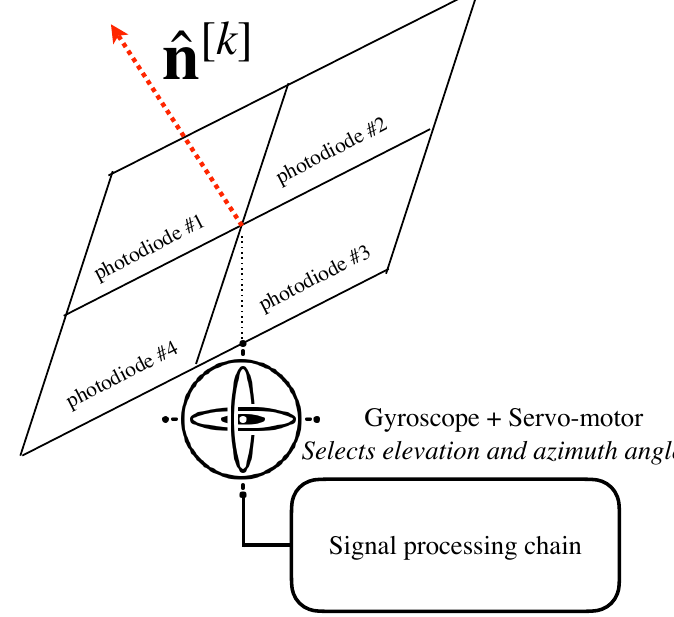
Figure 9. Variable receiving orientation angle